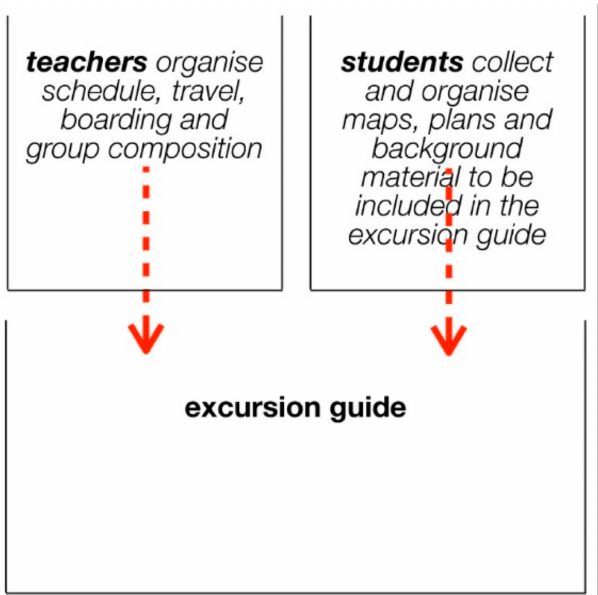
Figure 16. Preparation before; organisation and making of an excursion guide.